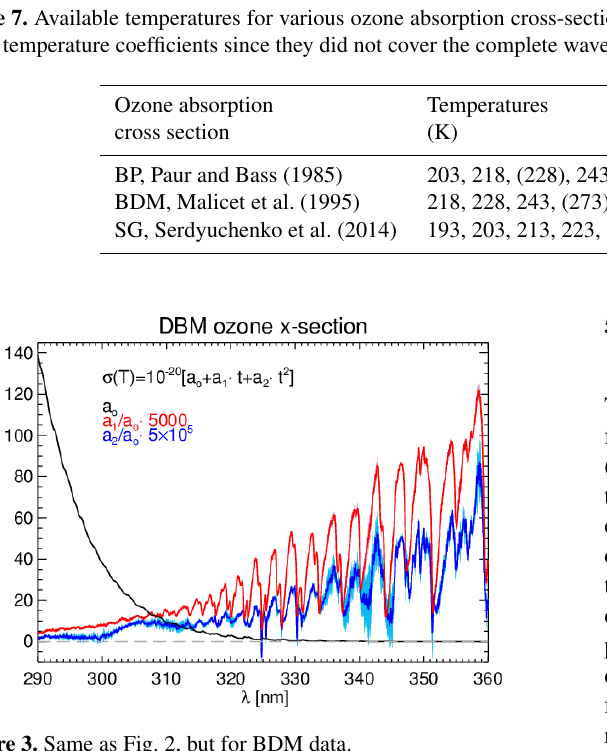
Figure 3. Same as Fig. 2, but for BDM data.